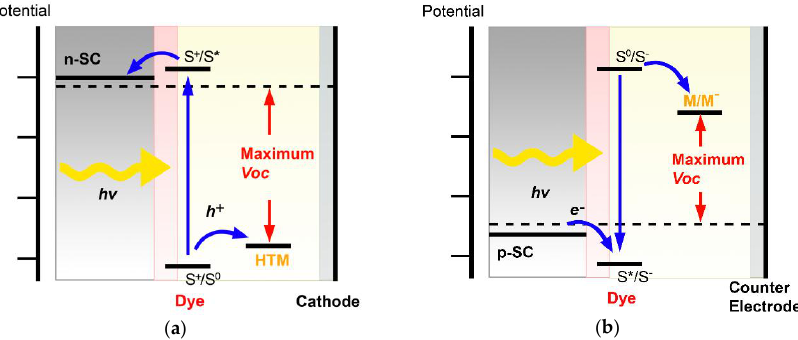
Figure 1. Schematic operating principle of ( a ) n-type solid-state dye-sensitized solar cell (SSDSC) and ( b ) p-type dye-sensitized solar cell (DSC) with a liquid electrolyte.